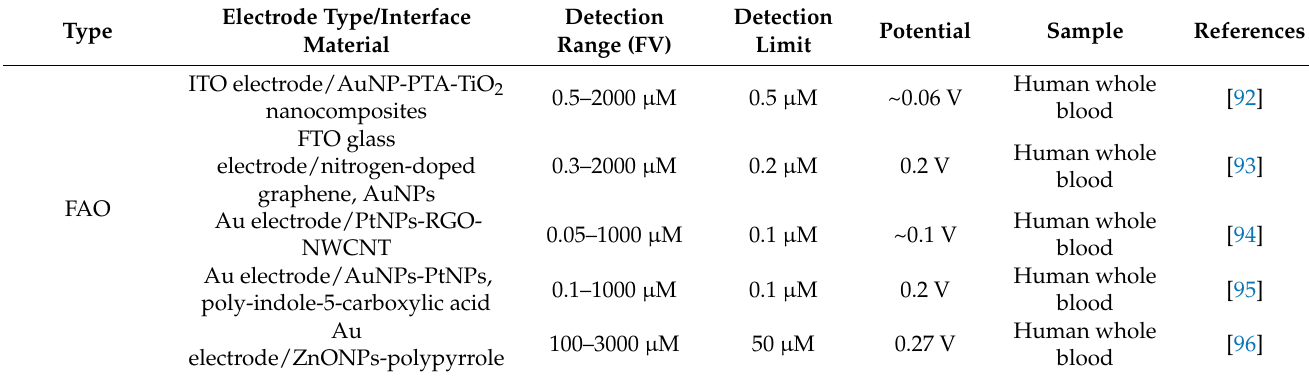
Table 2. Indirect type electrochemical HbA1c